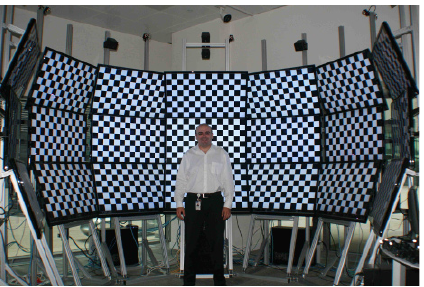
Figure 18. KAUST NexCAVE checkerboard pattern. Photo: Daniel